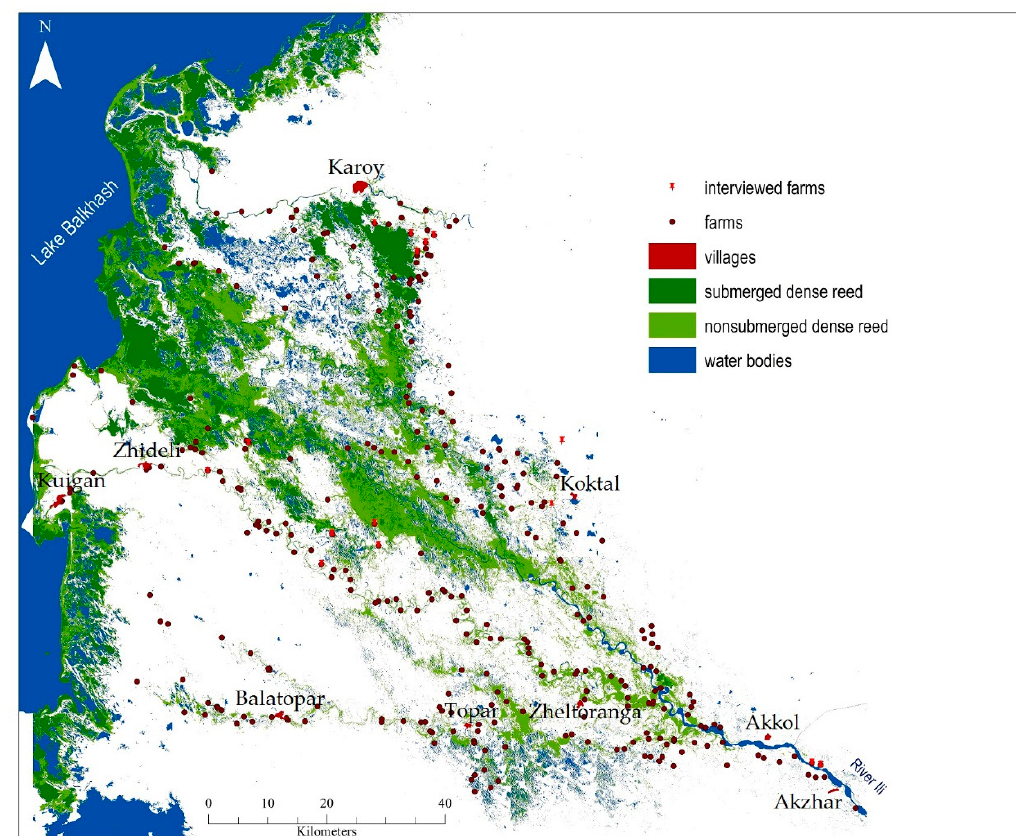
Figure 2. Overview of Ili Delta. Locations of 16 individual farms based on 2015 interview campaign (red pins, N = 16), other individual farms and agricultural enterprises (dark red dots, N = 310), and villages (red areas, N = 9). Land cover classes for 2014 based on the work in [5].